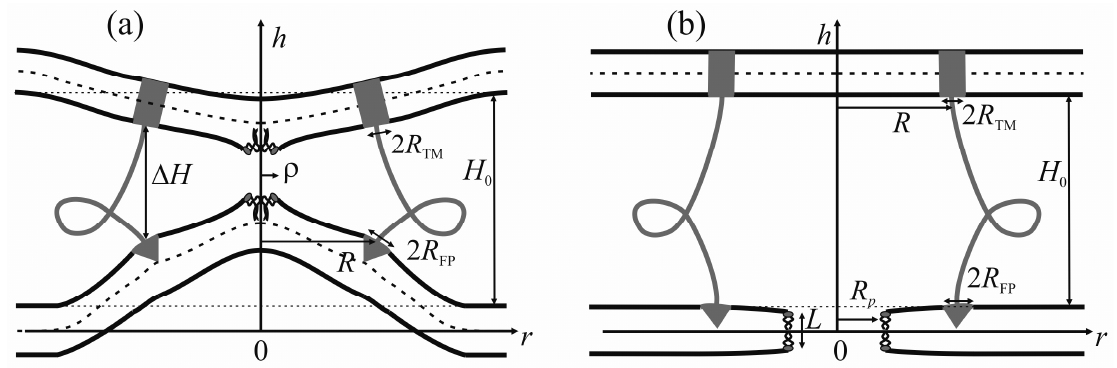
Figure 2. Schematic representation of the two alternative scenarios of evolution of the modeled system. ( a ) Stalk-mediated fusion: the distance ∆ H between the fusion peptides and the transmembrane domains of the fusion proteins in the membranes is assumed as the reaction coordinate; ( b ) Formation of the dead-end state ( π -shaped structure): the reaction coordinates are the pore radius R p and the length L of the hydrophobic part of the pore. The transmembrane domains (with the half-width of R TM ) are schematically shown as gray rectangles, the fusion peptides (with the half-width of R FP ) are represented by gray triangles. H 0 is the equilibrium distance between the membranes, ρ is the radius of the hydrophobic spot formed in the area of maximal proximity of the membranes.